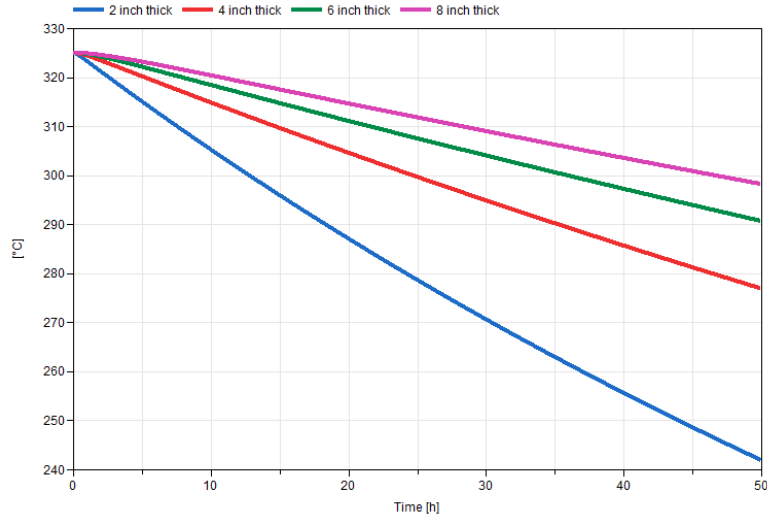
Figure 8. Thermocline temperatures with varying levels of insulation.